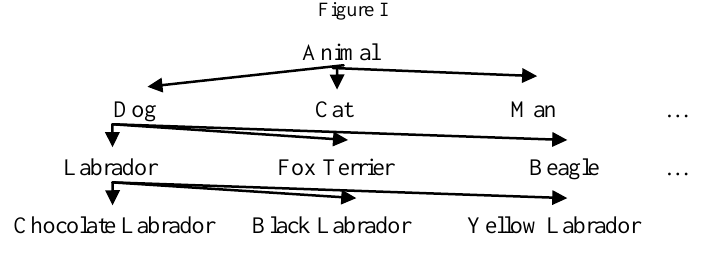
Animal Dog Cat Man … Labrador Fox Terrier Beagle … Chocolate Labrador Black Labrador Yellow